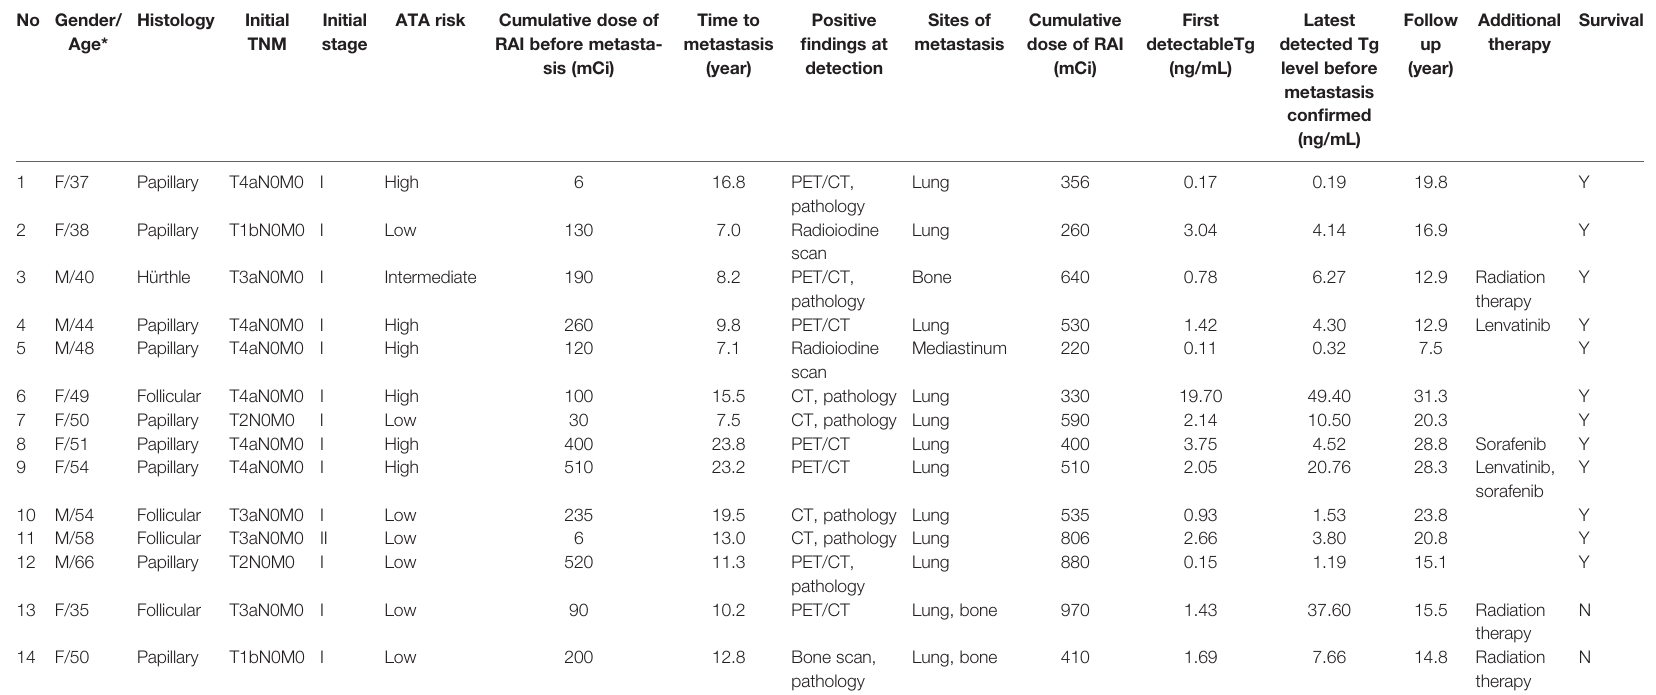
TABLE 2 | Details of 14 patients with distant